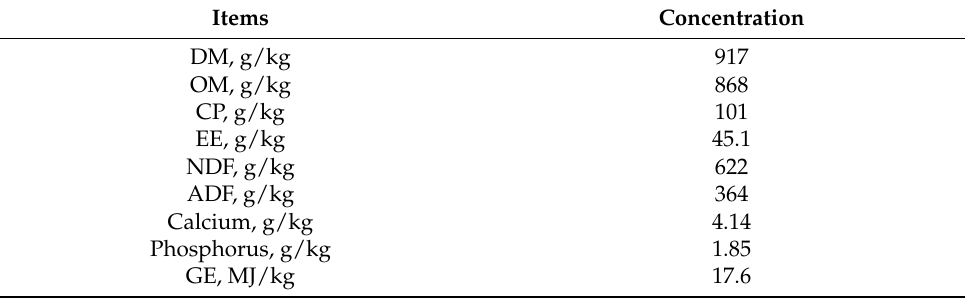
Table 1. The chemical composition of oat hay pellets (on DM basis). Items Concentration DM, g/kg 917 OM, g/kg 868 CP, g/kg 101 EE, g/kg 45.1 NDF, g/kg 622 ADF, g/kg 364 Calcium, g/kg 4.14 Phosphorus, g/kg 1.85 GE, MJ/kg